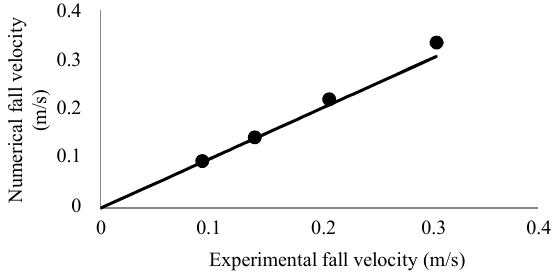
Fig. 9. Agreement between experimental data of ferguson and Church (2004) and numerical data